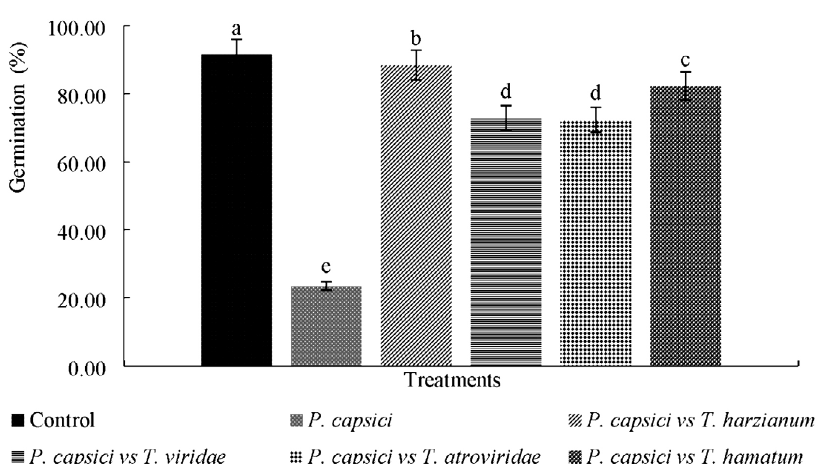
Fig. 2. Comparison of Germination Percentage of Manzano chili seeds inoculated with native strains of Trichoderma spp., and P. capsici in nursery.*Different letters mean significant difference between treatments according to Tukey-Kramer ( p <